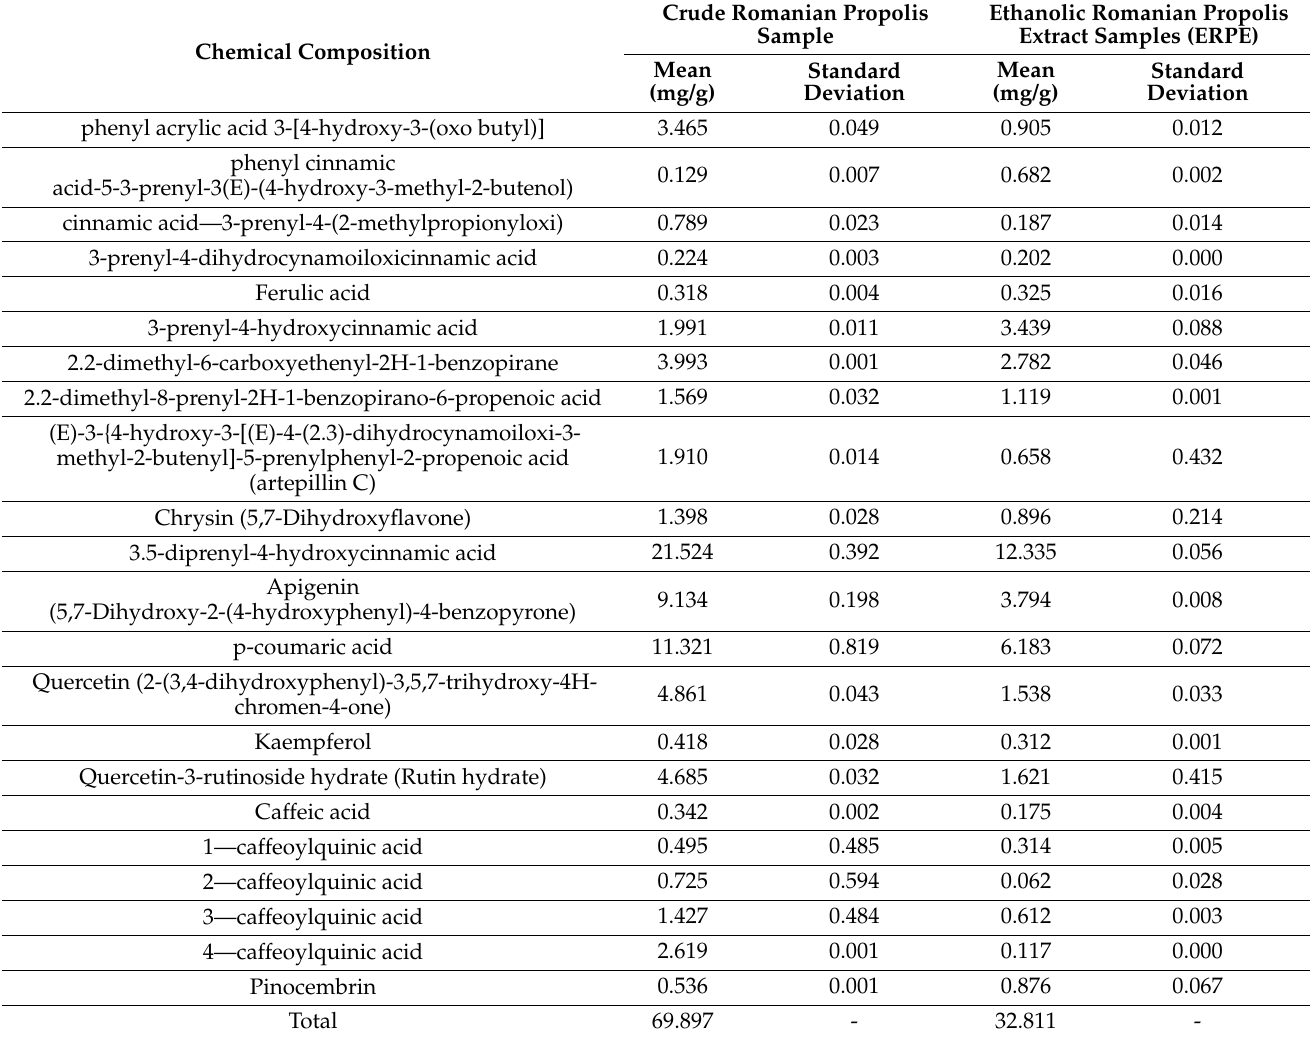
Table 1. The chemical composition of a crude sample of Romanian propolis and its ethanolic extract was determined (quantitative